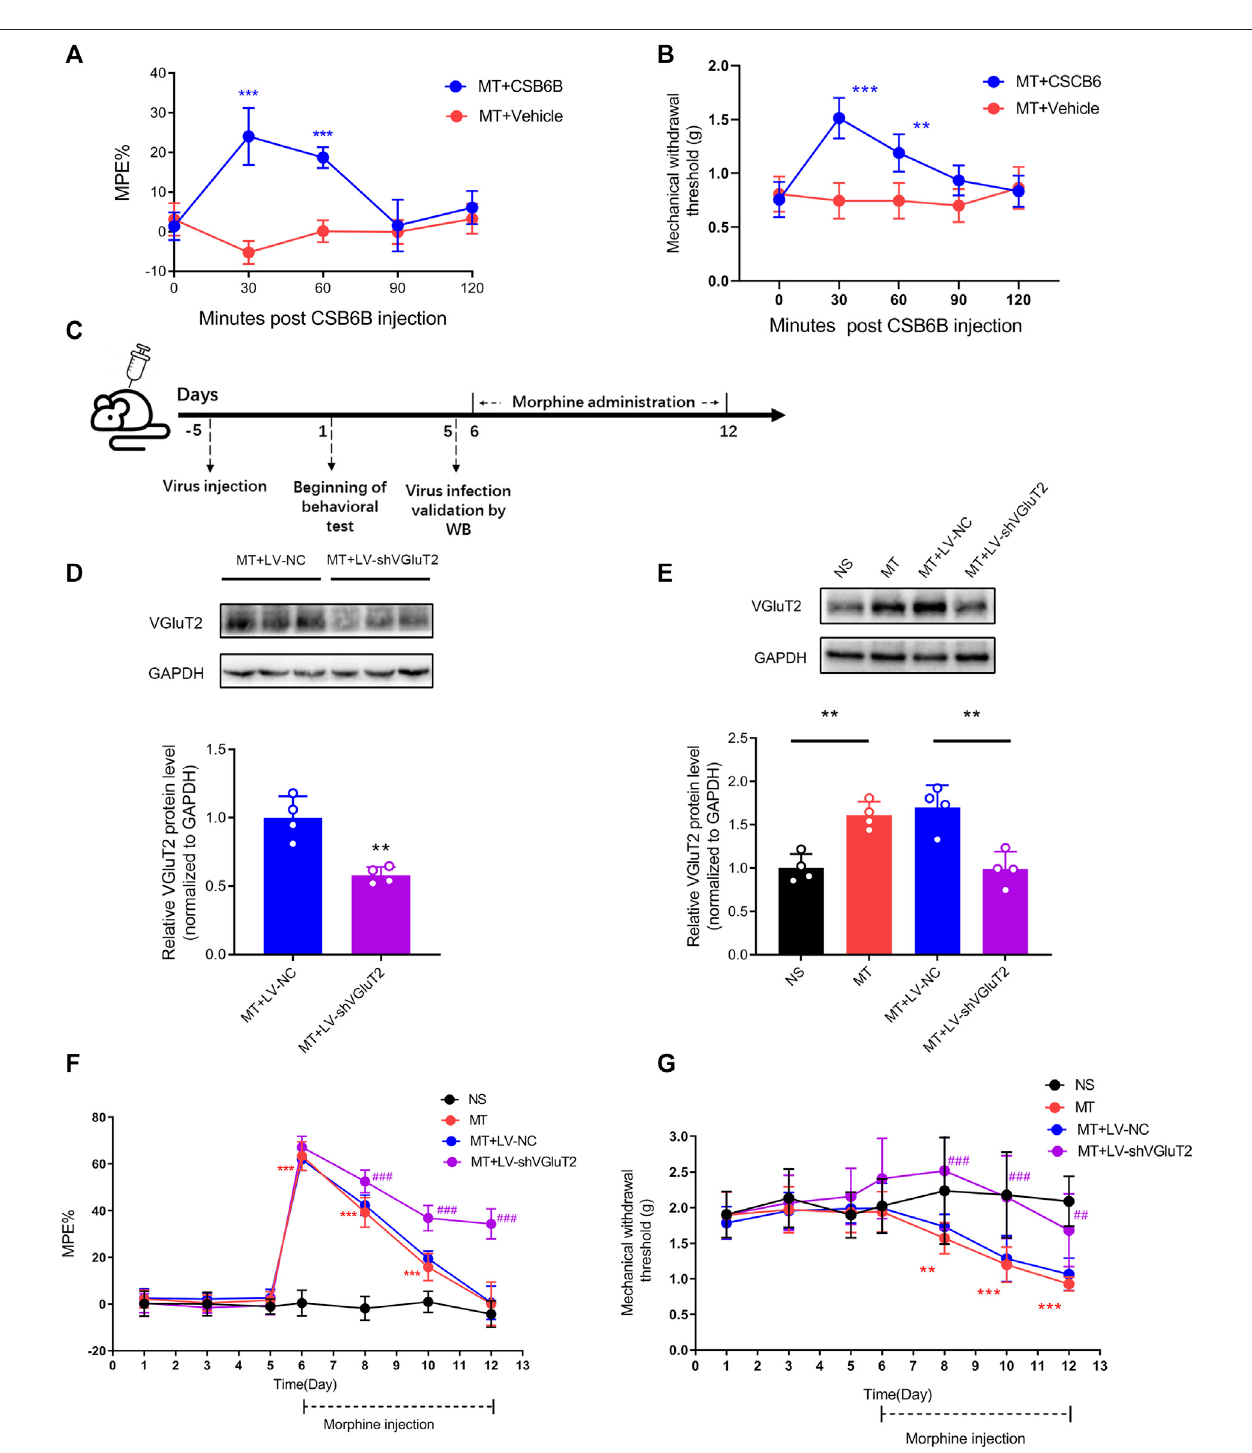
FIGURE3| InhibitionorknockdownofVGluT2attenuatesthedevelopmentofmorphinetolerance (A) EffectofintrathecalinjectionofVGluT2inhibitorCSB6B(5 μ g/ 5 μ L) on morphine-induced tolerance assessed by the tail- fl ick test. n = 6, MT + CSB6B versus MT + Vehicle, two-way ANOVA, F (1, 10) = 67.34, p < 0.0001 with Bonferroni correction; *** p < 0.001, compared with MT + Vehicle (B) Effect of CSB6B (5 μ g/5 μ L) on morphine-induced mechanical hyperalgesia. n = 6, MT + CSB6B versus MT + Vehicle, two-way ANOVA, F (1, 10) = 26.37, p = 0.0004 with Bonferroni correction; ** p < 0.001, *** p < 0.001, compared with MT + Vehicle (C) Experimental schematic diagram showing virus injection, behavioral tests, virus ef fi ciency validation as well as morphine administration in mice expressing scrambled RNAandshVGluT2 (D,E) Westernblottingtestshowingef fi cientVGluT2knockdowninthespinalcord (D) VGluT2wasef fi